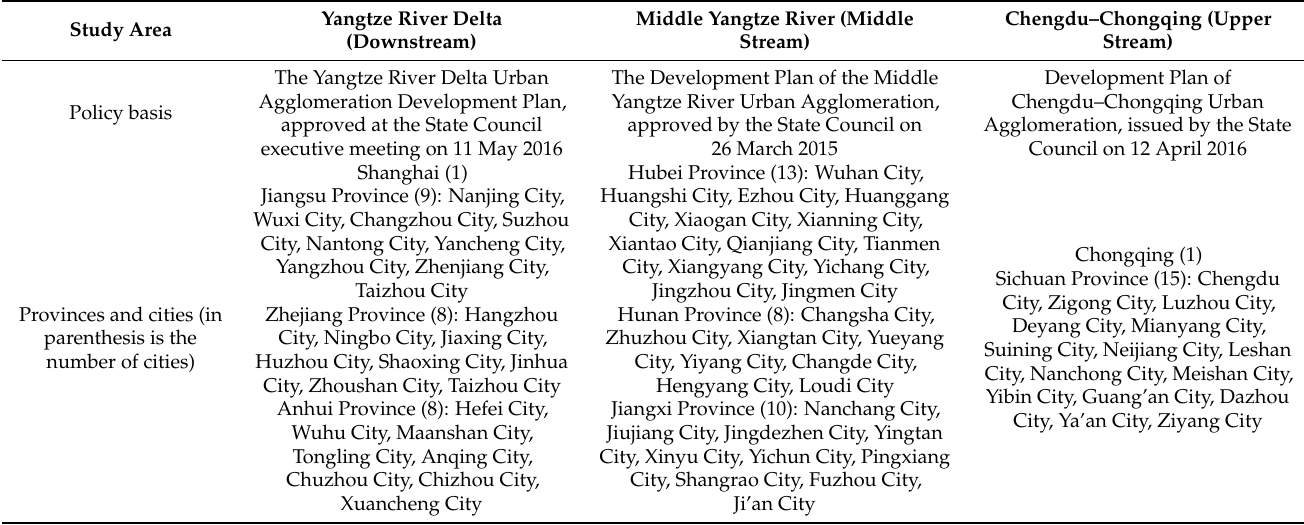
Table A1. List of provinces and cities corresponding to three urban